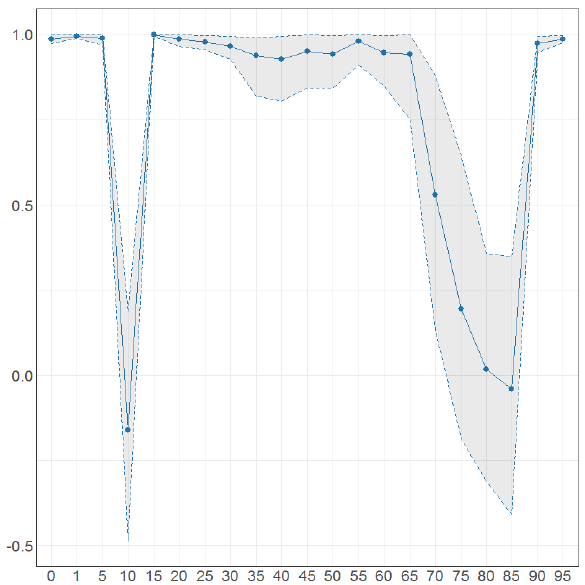
Figure 29. Bayesian posterior mean estimators with 95% posterior credible intervals for the estimation of the age-specific diagonal elements of the transition matrix Ω (x axis ) under DFM-PC-B.